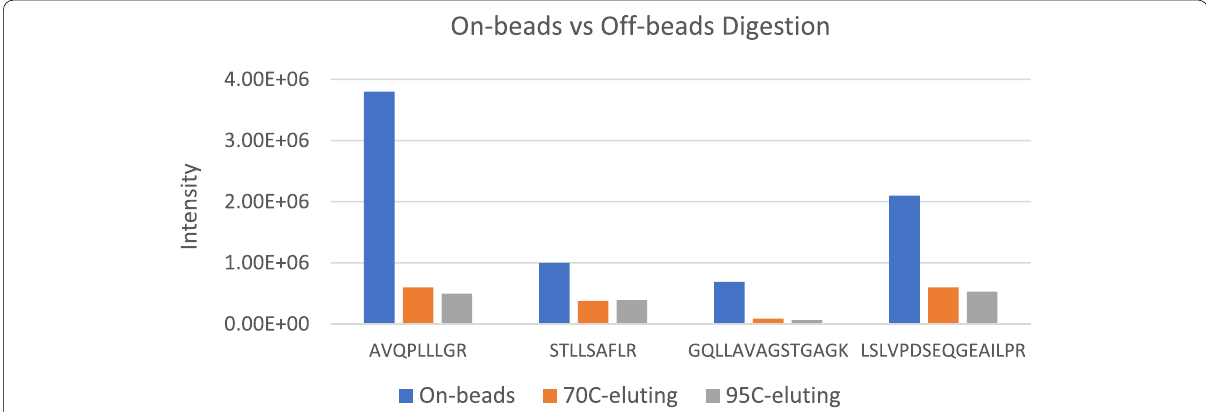
Fig. 4 Comparison of peak intensities of four hCFTR peptides (AVQPLLLGR, STLLSAFLR, GQLLAVAGSTGAGK and LSLVPDSEQGEAILPR) generated by on-beads digestion vs off-beads digestion. hCFTR protein (5 ng) spiked in mouse lung membrane protein extracts (50 mg lung tissue) was used as